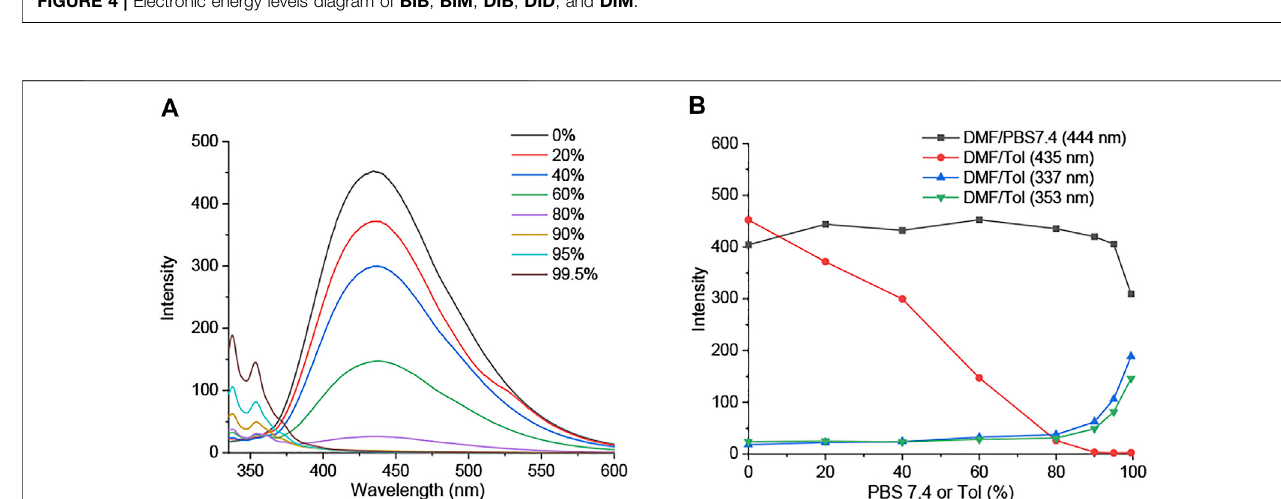
FIGURE 4 | Electronic energy levels diagram of BIB , BIM , DIB , DID , and DIM .